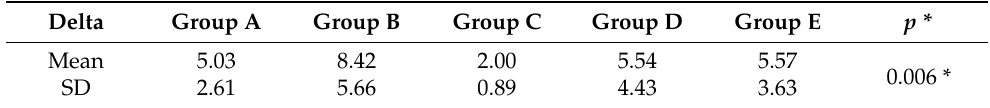
Table 5. Comparison of means and SDs of ∆ E among the different groups tested using Kruskal-Willis nonparametric test. Delta Group A Group B Group C Group D Group E p *